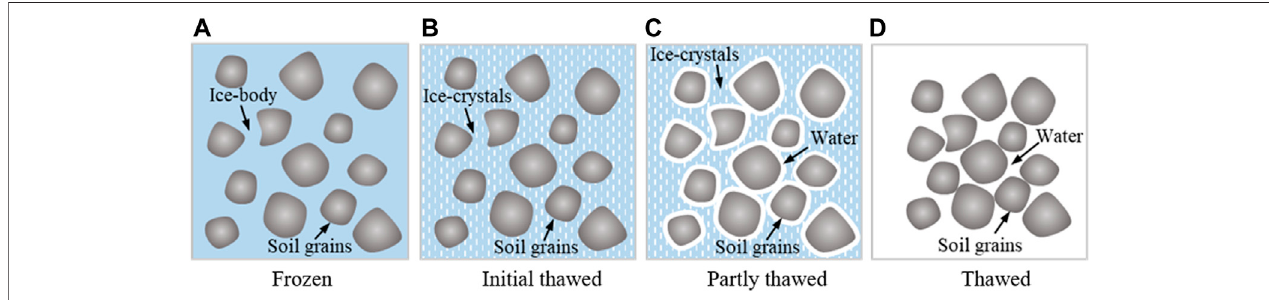
FIGURE 9 | Different states in frozen specimens during thawing. (A) Frozen state; (B) initial thawed state; (C) Partly thawed state; (D) Thawed